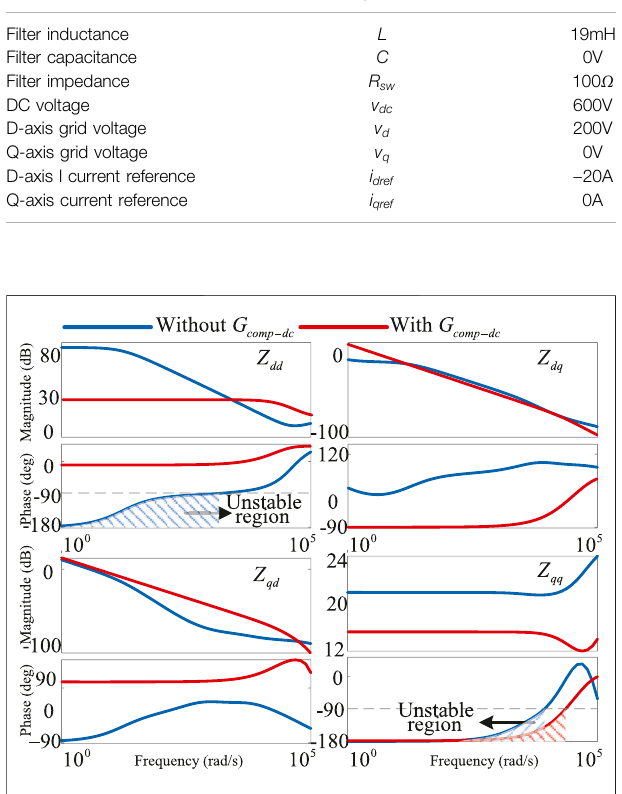
FIGURE 12 | Impedance frequency characteristics with and without G comp − dc